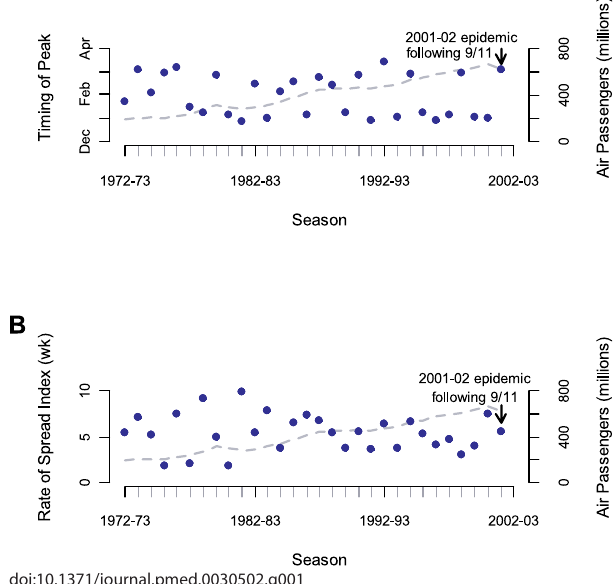
Figure 1. Infl uence of United States Airline Volume on Infl uenza Spread and the Timing of Yearly Transmission over 30 Infl uenza Seasons (A) The association between airline travel from September to December and the timing of the US infl uenza peak is displayed. Airline volume signifi cantly predicts the timing of seasonal infl uenza mortality ( r 2 = 0.460; p < 0.001). The timing of seasonal national infl uenza mortality (blue dots) is estimated from cross-correlation of each season with the 1972–1973 season. (B) The association between airline travel from September to December and time to transnational US spread is displayed. The numbers of traveling domestic passengers signifi cantly predicts transnational infl uenza spread ( r 2 = 0.265; p = 0.004). Index spread of infl uenza (blue dots) is estimated from the 99% confi dence interval of the cross-correlation values for the nine major geographic regions of the United States against the national curve for a give year, as previously described